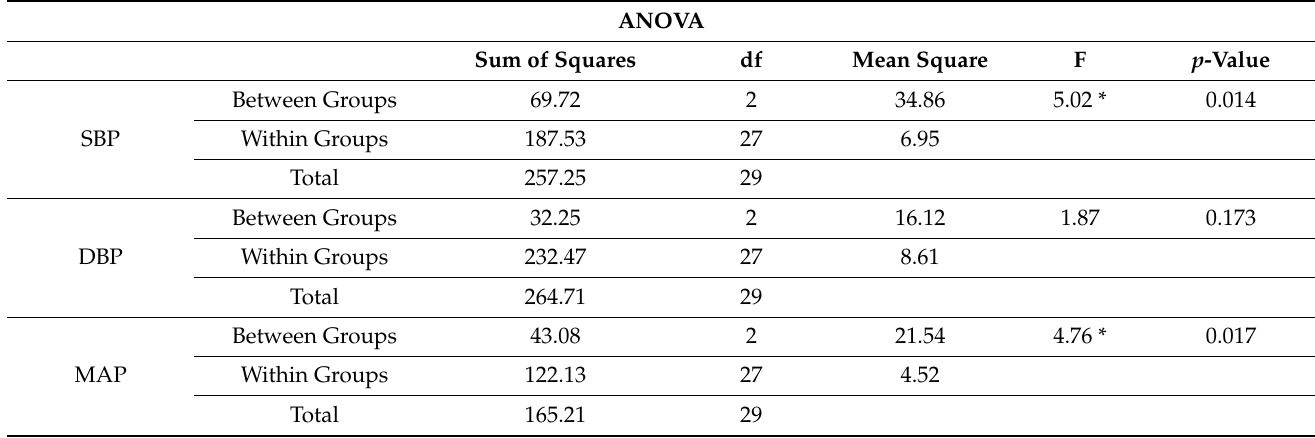
Table 4. Comparison of SBP, DBP and MAP mean difference across the 3